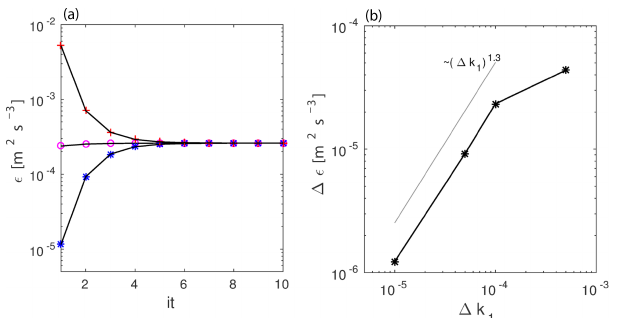
Figure 10. (a) Values of (cid:15) calculated during the iterative procedure for different initial guesses of (cid:15) 0 . (b) Error of (cid:15) as a function of (cid:49)k . The reference value is (cid:15) calculated with (cid:49)k = 5 × 10 − 6 m − 1 .